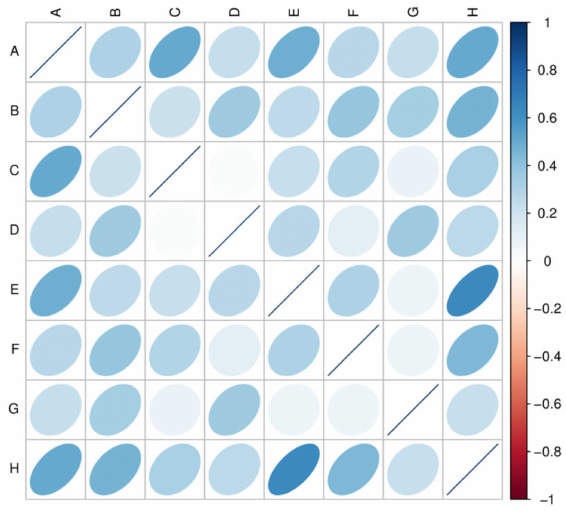
Figure 5. Heatmap of the correlation coefficient between samples. In the figure, different colours represent the Spearman correlation coefficient; see the legend on the right for the relationship between the correlation coefficient and colour. The darker the colour is, the greater the absolute value of the correlation coefficient between samples. The right deviation of the ellipse indicates that the correlation coefficient is positive and the left deviation is negative. The flatter the ellipse, the larger the absolute value of the correlation